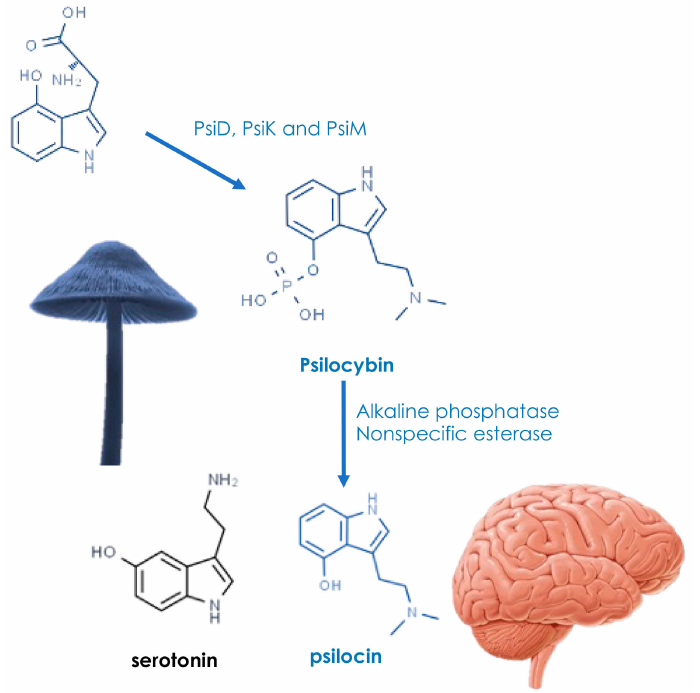
Figure 5. Chemical structures and biosynthesis pathway of the indole alkaloids in magic